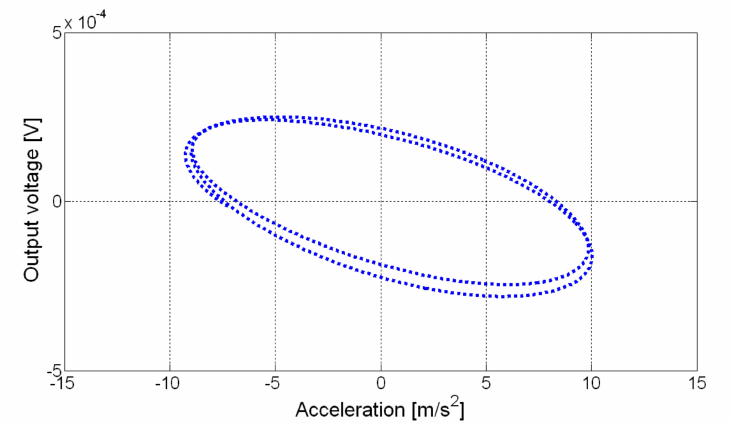
Figure 11. The output voltage of the accelerometer as a function of the applied acceleration. The reported curves refer to different amplitudes of the applied input.